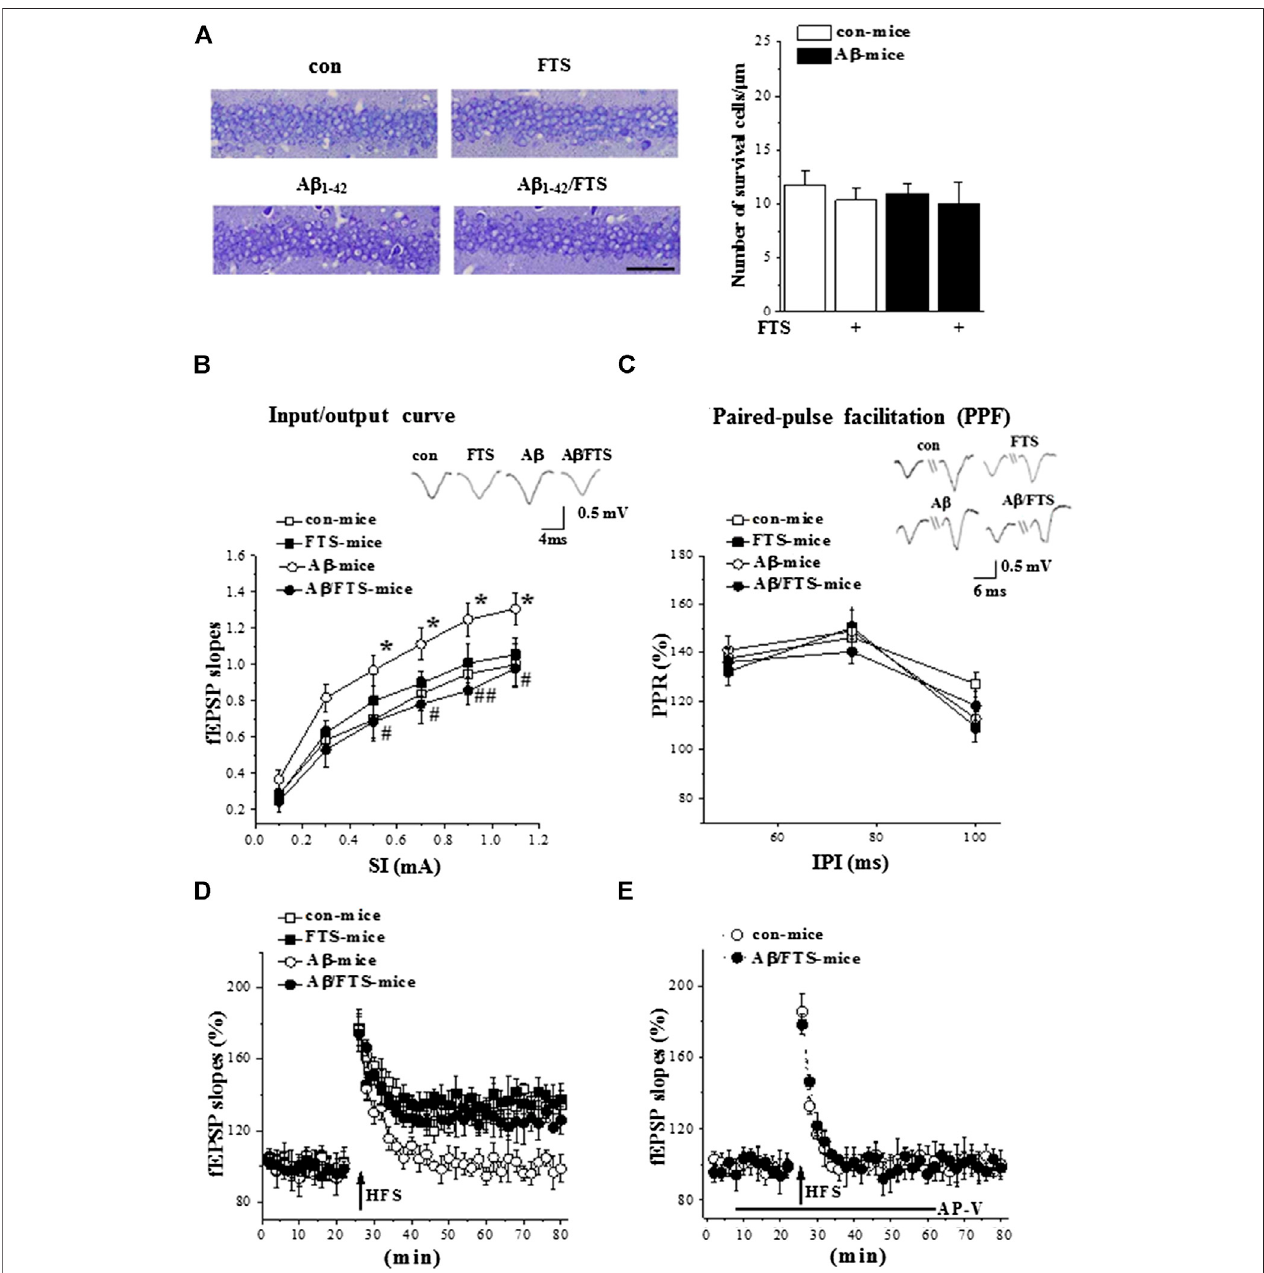
FIGURE3| A β 1-42 -activatedRasenhancessynaptictransmissionandimpairsLTP. (A) RepresentativehippocampalCA1imagesinmice.Scalebars (cid:1) 50 μ m.Bar graph represents the counts of surviving pyramidal cells (two-way ANOVA, n (cid:1) 6 per group). (B) fEPSPs slopes were plotted against intensity of test stimuli from 0.1 to 1.1 mA.Typicaltracesevokedbyatestingstimulation(0.5 mA).* p < 0.05vs.controlmice;# p < 0.05and## p < 0.01vs.A β 1-42 -mice(repeated-measuresANOVA,n (cid:1) 8 per group). (C) Paired-pulse ratios of fEPSP slopes were plotted against interpulse intervals (IPIs) of stimuli from 50 to 100 ms. Typical traces evoked with IPI of 75 ms (repeated-measures ANOVA, n (cid:1) 8 per group). (D) Effects of FTS on A β 1-42 -impaired induction of LTP. A solid arrow indicates when HFS was given. (E) NMDAR dependency of LTP induction. Black line indicates duration of NMDAR antagonist AP-V applied.